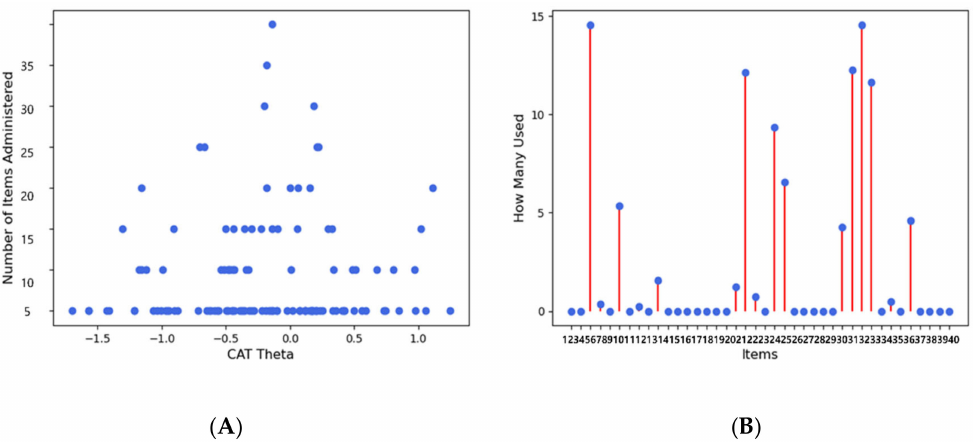
Figure 5. Items were adaptively chosen based on a leaner’s ability. ( A ) The number of items used in terms of a learners’ abilities. ( B ) The number of items selected from an item bank.